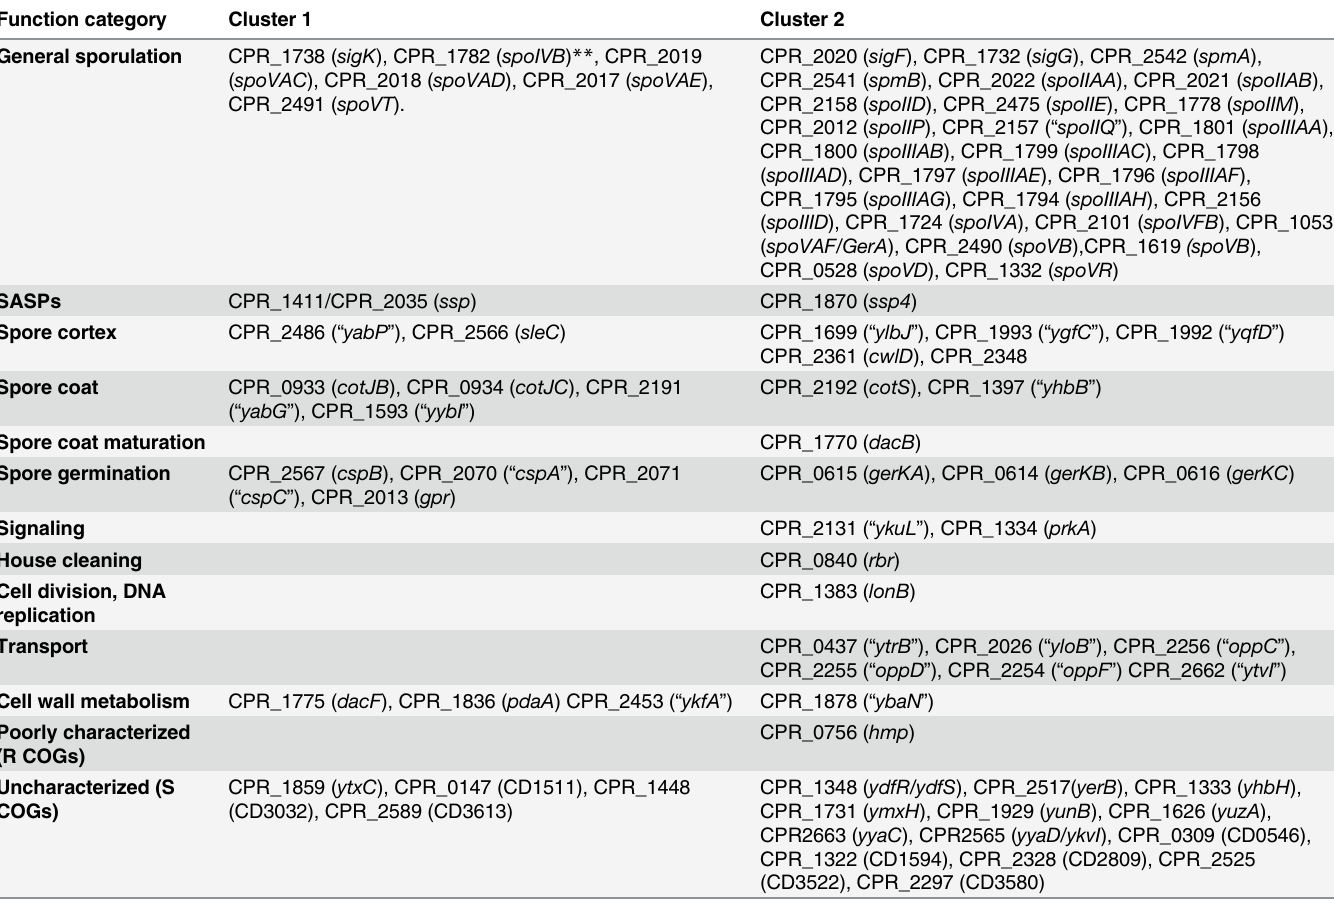
Table 2. Cluster 1 and 2 C . perfringens homologs of known sporulation genes summarized by Galperin and colleagues [8] *